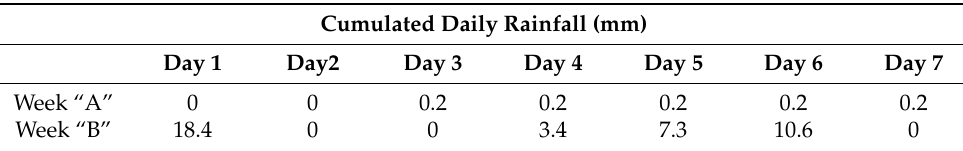
Table 4. Cumulated daily rainfall (mm) for two weeks: week “A” and week